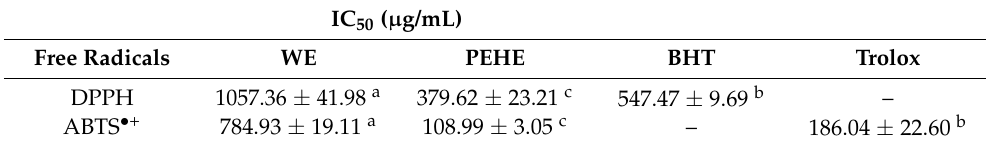
Each value represents the mean ± SD of triplicate experiments. Values with different letters within the same row are significantly different ( p < 0.05).